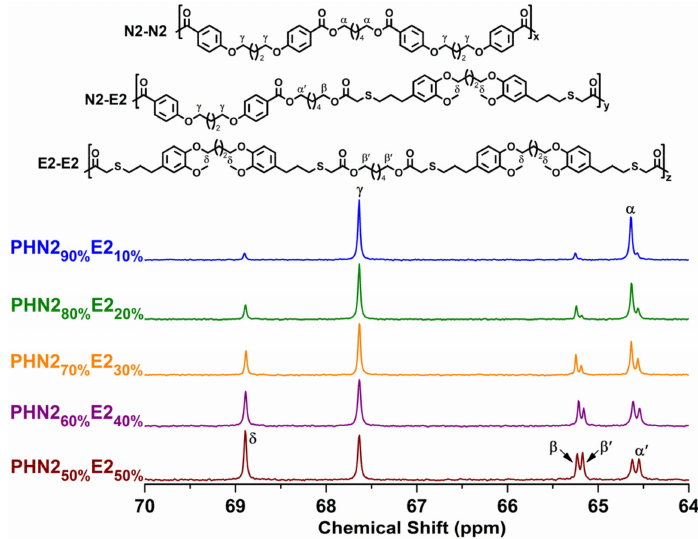
Figure 4. The splitting modes of the methylene carbons adjacent to the alcohol-oxygens for PHN2 1 − x E2 x with the indications of the dyads to which they are